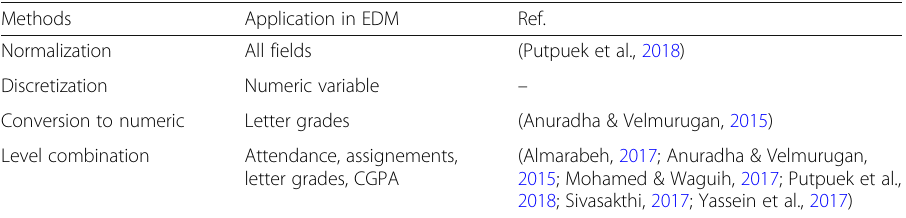
Table 11 Data transformation